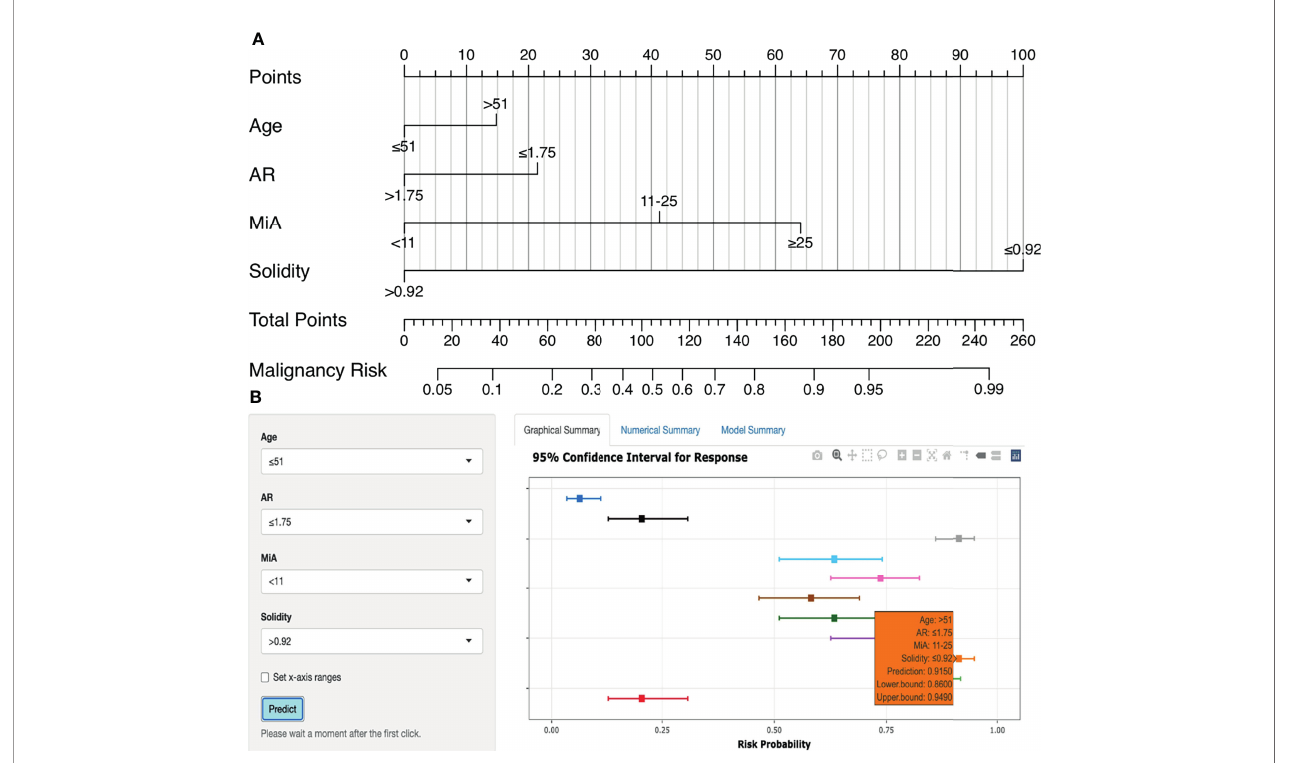
FIGURE 6 | Nomogram and online risk calculator. (A) Nomogram based on US morphometric features. Applications of the nomogram were exempli fi ed in Supplementary Figure 5 . (B) The online calculator application version of the